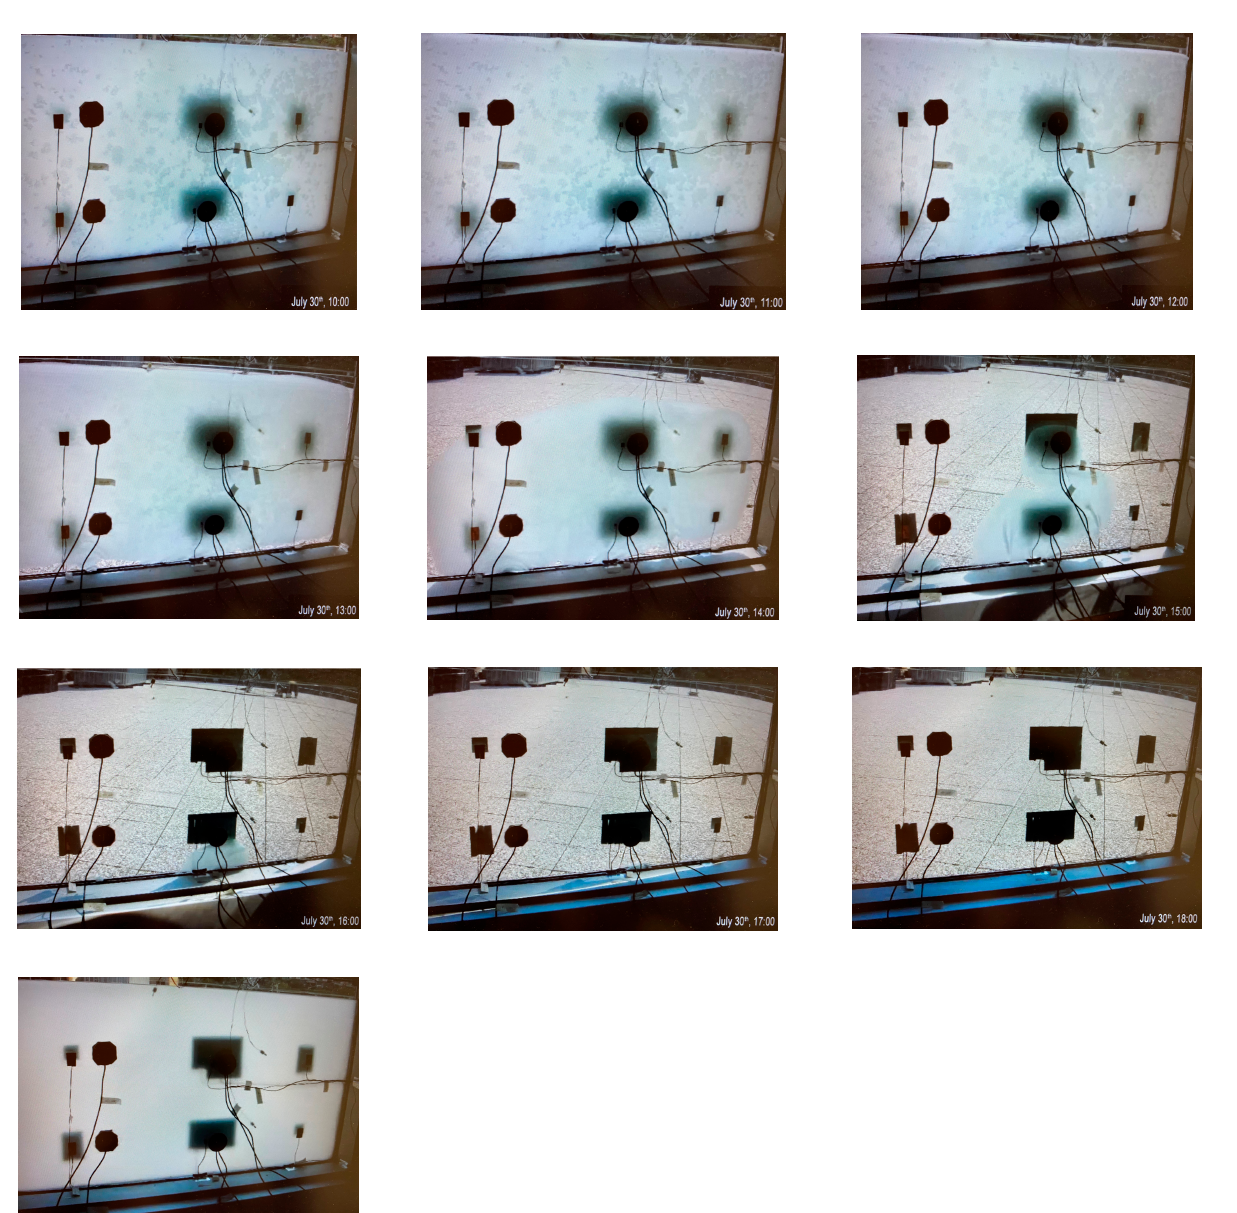
Figure 16. Changes in the aggregate state and transparency of wax in the façade (data from ref. [136]) .